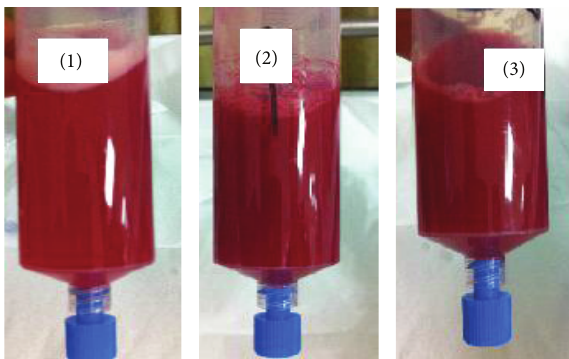
Figure 2: Bronchoscopy, bronchoalveolar lavage: The images show serial samples returned from bronchoalveolar lavage demonstrating progressive, hemorrhagic samples. These findings were consistent with diffuse alveolar